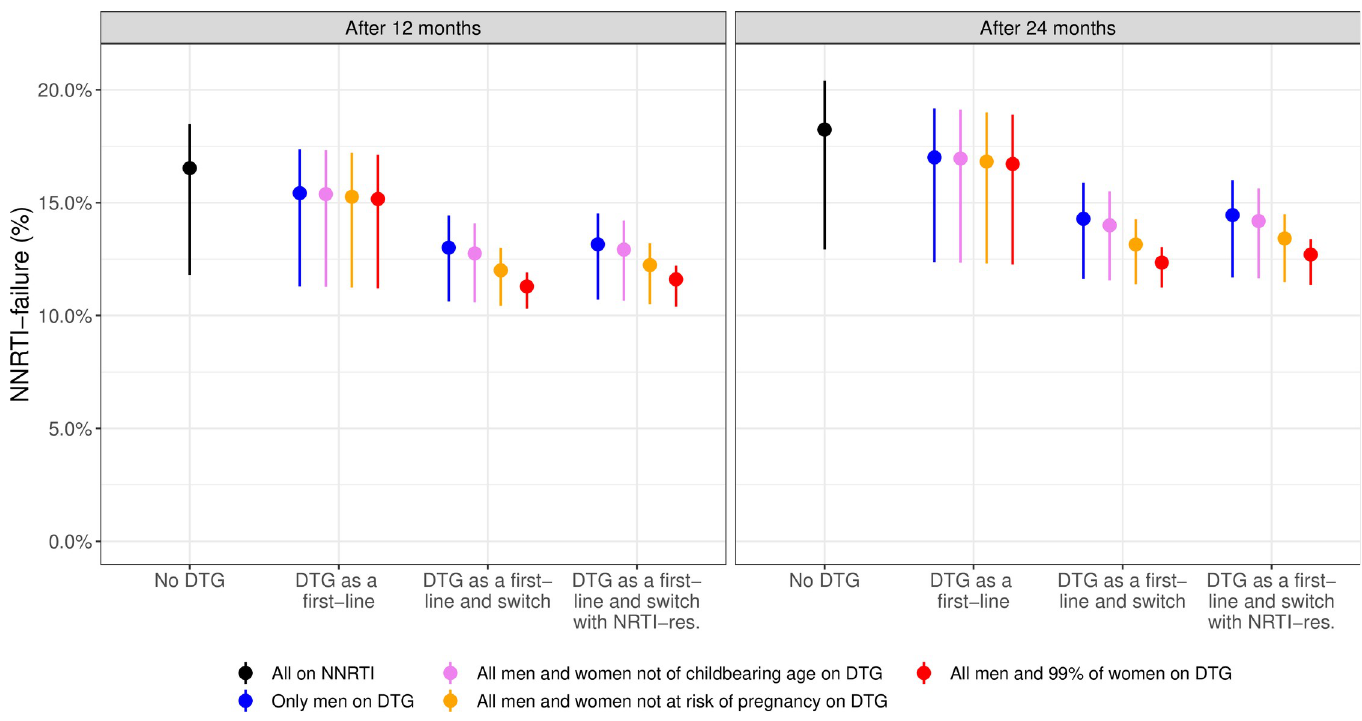
Fig 5. Predicted percentage of women failing NNRTI-based ART after 1 and 2 years of ART in 2035, depending on the scenario of the rollout of DTG-based ART. Note that the scenario in which DTG is given to all men and 99% of women (in red) replaces the scenario in which DTG was given to all men and women (see “Additional analyses”). Failure is given after 1 and 2 years of ART. ART, antiretroviral therapy; DTG, dolutegravir; NNRTI, non-nucleoside reverse transcriptase inhibitor.